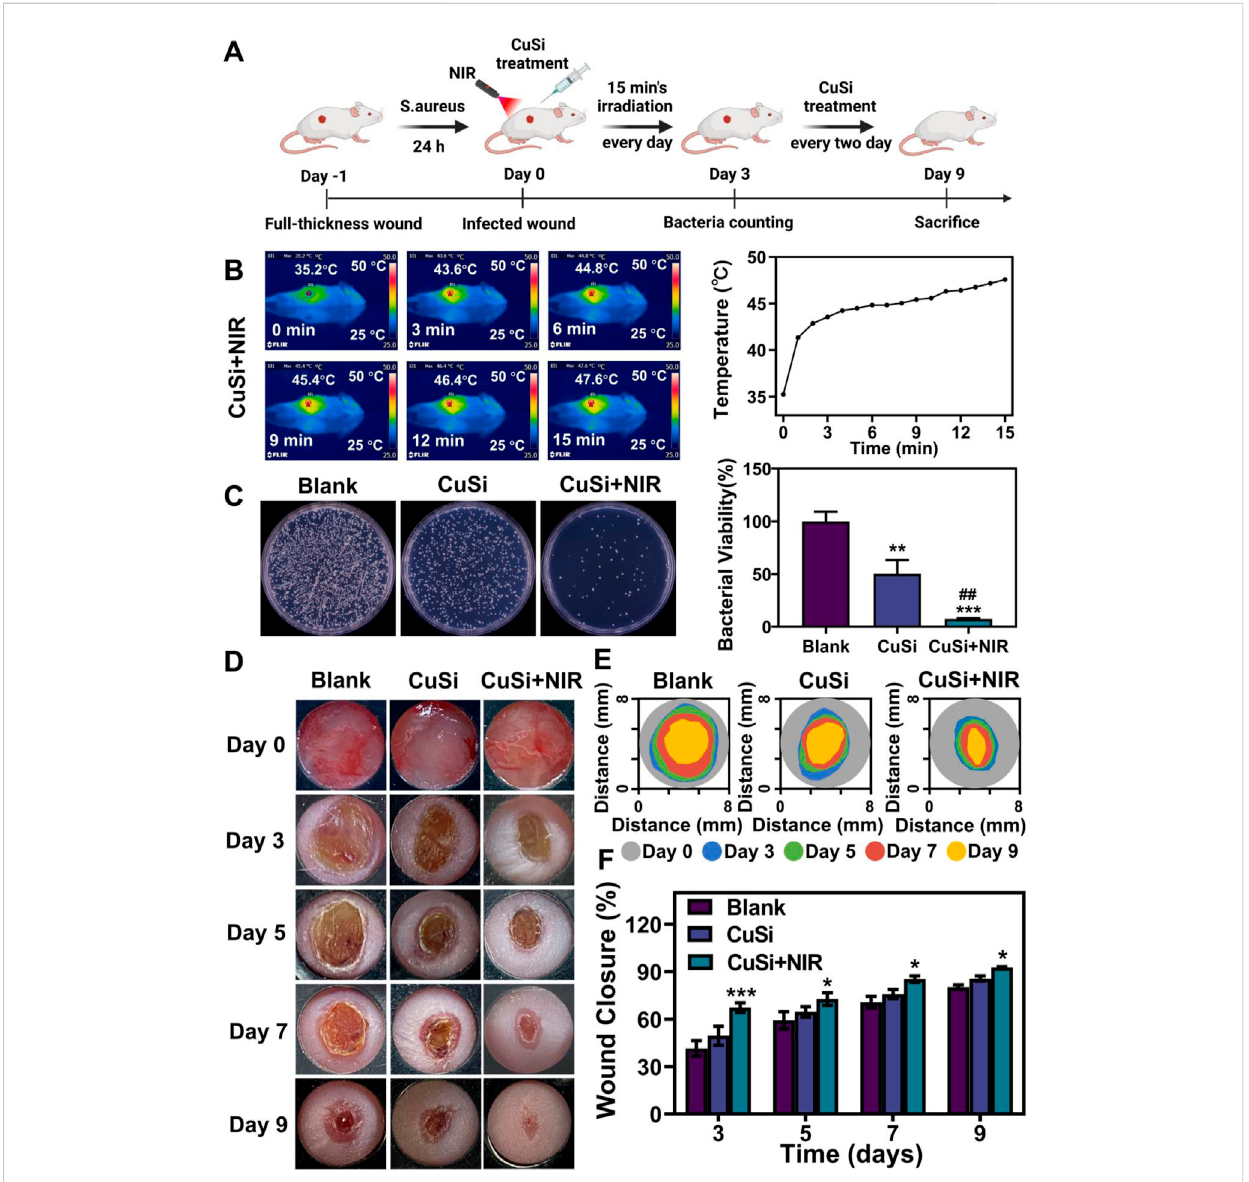
FIGURE 6 Treatment of infected wounds with CuSi NWs. (A) Schematic diagram of the protocol for the establishment of an infection model and the course of treatment. (B) Representative thermal images and the corresponding photothermal heating curves of the wound site treated with CuSi NWs under the irradiation of NIR light. (C) Representative photos and bacterial viability of S. aureus in wound site after different treatments ( n = 6). The Blank group was normalized. (D) Representativephotos, (E) sizemarkers,and (F) quantitativeclosurerateofthewoundswithdifferenttreatmentsonday3,5,7,and9, respectively ( n = 6). Figure 5A was created with BioRender.com. * p < 0.1, ** p < 0.01, or *** p < 0.001 vs. Blank group; # p < 0.05 or ## p < 0.01 or ### p < 0. 001 vs. CuSi